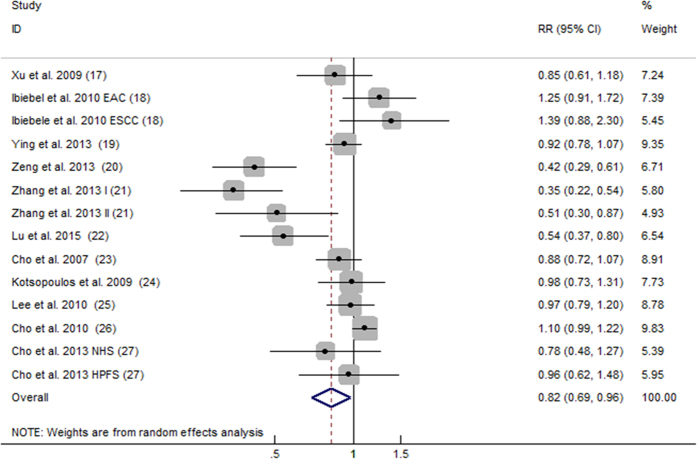
Forest plot of highest versus lowest categories of choline consumption on cancer risk.RR, relative risk; CI, confidence interval; EAC, esophageal adenocarcinoma; ESCC, esophageal squamous cell carcinoma; I, stage one; II stage two; HPFS, The Health Professionals Follow-up Study; NHS, The Nurses’ Health Study.